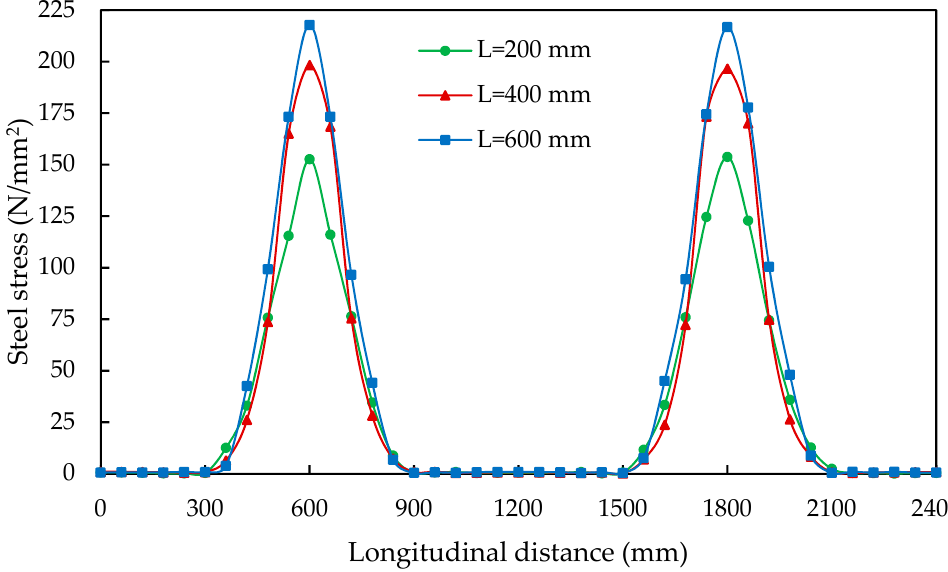
Figure 15. Comparison of maximum steel stress over along the length of the longitudinal steel bar for different saw-cut lengths.